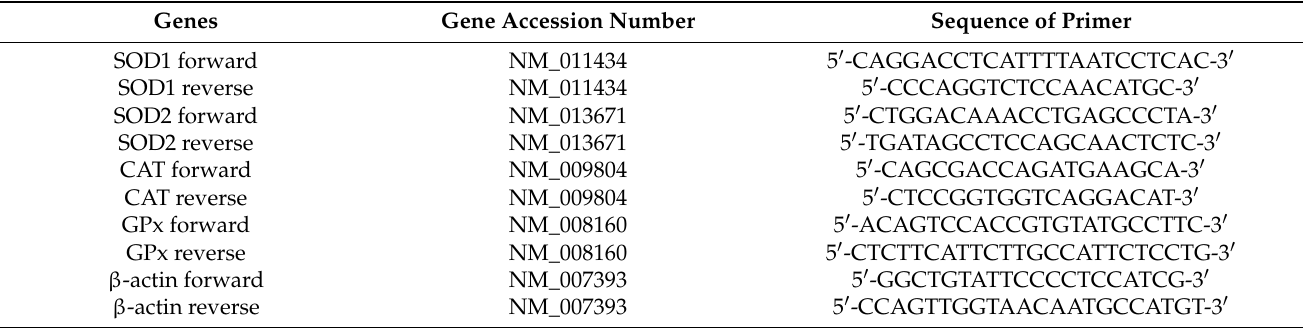
Table 1. List of